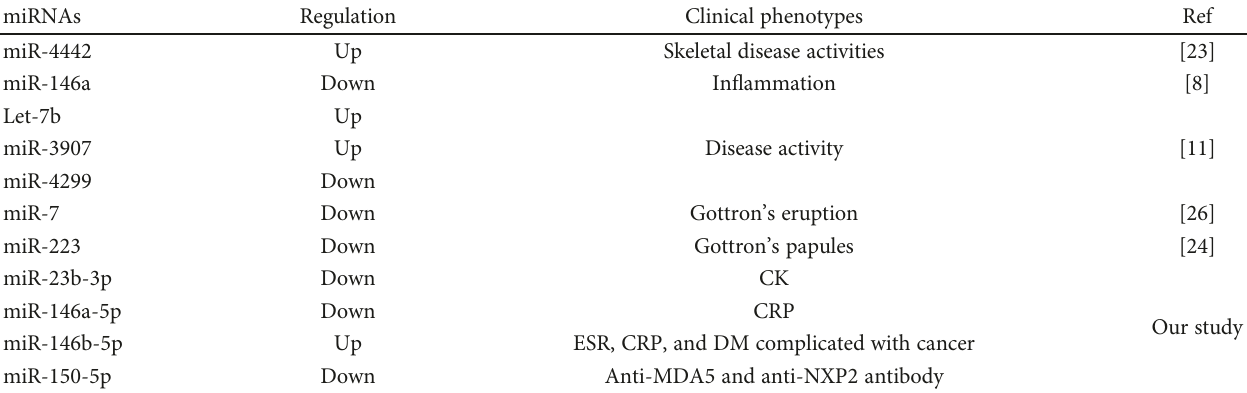
Anti-MDA5 and anti-NXP2 antibody DM: dermatomyositis; CK: creatine kinase; CRP: C-reactive protein; ESR: erythrocyte sedimentation rate; anti-MDA5: anti-melanoma di ff erentiation-associated gene 5; anti-NXP2: anti-nuclear matrix